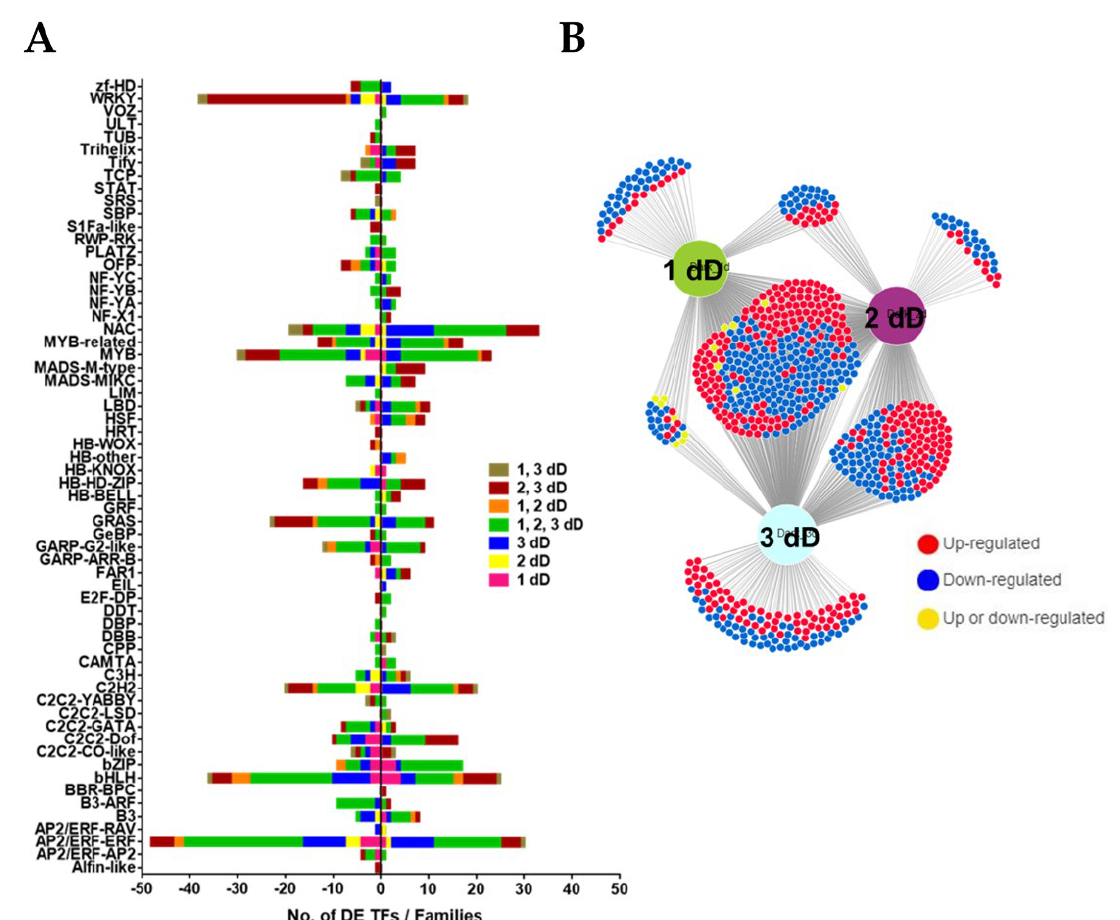
Figure 6. Transcriptional regulation of dark-induced senescence. ( A ) Graphical representation of differentially expressed transcription factor families at 1 d, 2 d, 3 d vs. 0 d of dark treatment (dD). ( B ) Venn diagram analysis showing overlap among differentially expressed transcription factors in M3 leaves at 1 d, 2 d, 3 d vs. 0 d of dark treatment using DiVenn. Table 2. Transcription factors ’ families with distinct expression kinetics during dark-induced senes- cence, identified via STEM analysis.